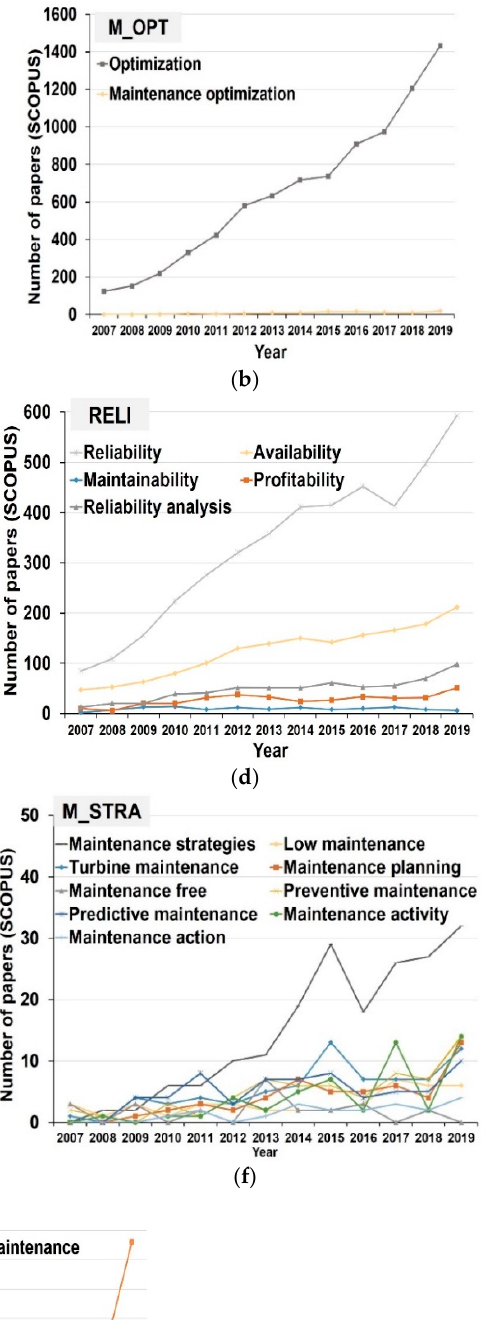
Figure 3. Wind energy O&M cost fields: number of papers in Scopus.